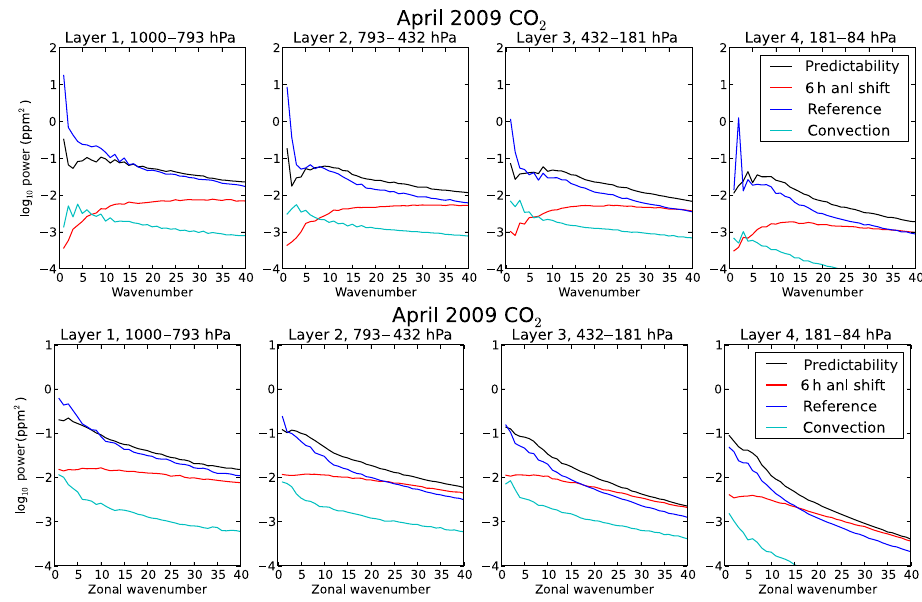
Figure 13. As in Fig. 11 but for spectra in April 2009 and now errors due to the removal of convective tracer transport are shown as cyan curves. Spectra are shown as a function of total wavenumber (top row) or zonal wavenumber (bottom row). Note that only wavenumbers up to 40 are